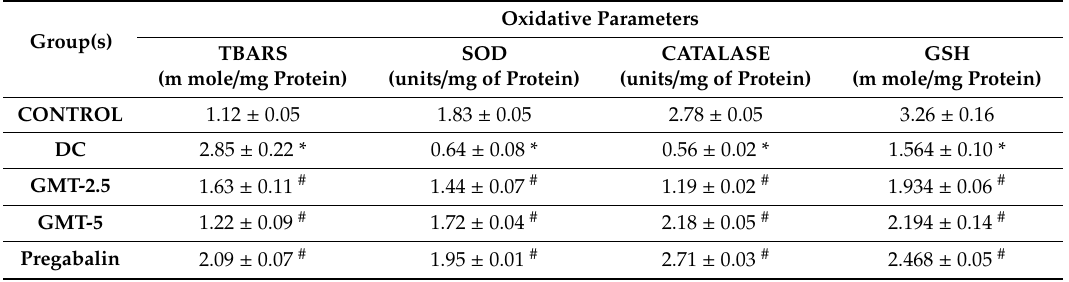
Table 6. E ff ect of chloroform extract of goat milk treated A. napellus on oxidative biomarkers. Oxidative Parameters Group(s) TBARS SOD (m mole / mg Protein) (units / mg of